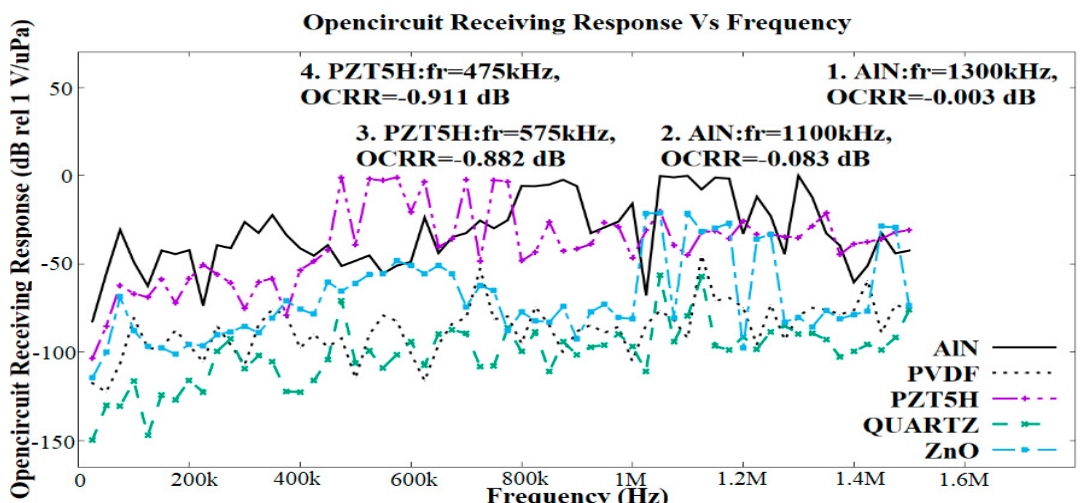
Figure 6. FEA simulation results regarding the effects of the piezoelectric material membranes, such as AlN, PVDF, PZT5H, quartz, and ZnO, on the PMUT in terms of the open-circuit receiving response (OCRR) vs. frequency. PZT5H shows two resonance frequency points at 475 and 575 kHz, with OCRR values of − 0.911 and − 0.882 dB, respectively. For the targeted application, PZT5H was found to